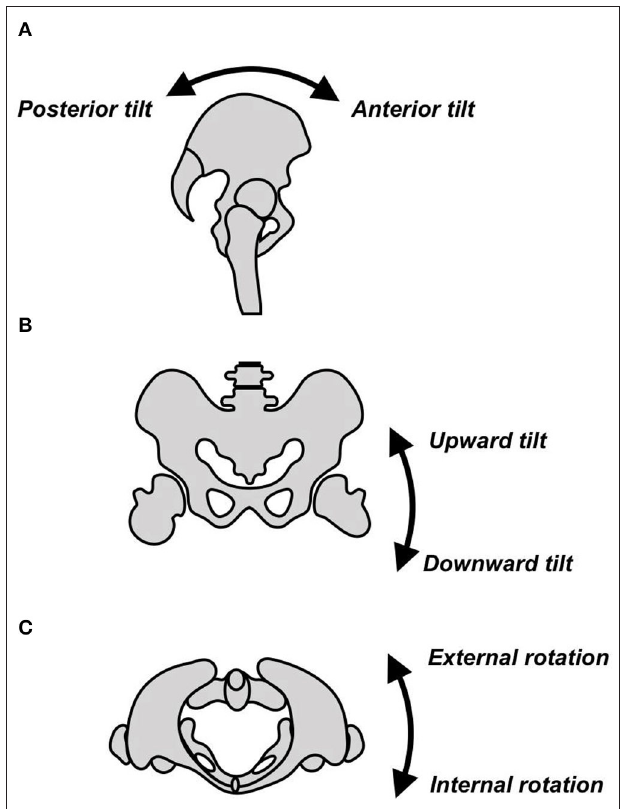
FIGURE 3 | Movement of the pelvis in (A) the sagittal plane, (B) the frontal plane, and (C) the transverse plane.